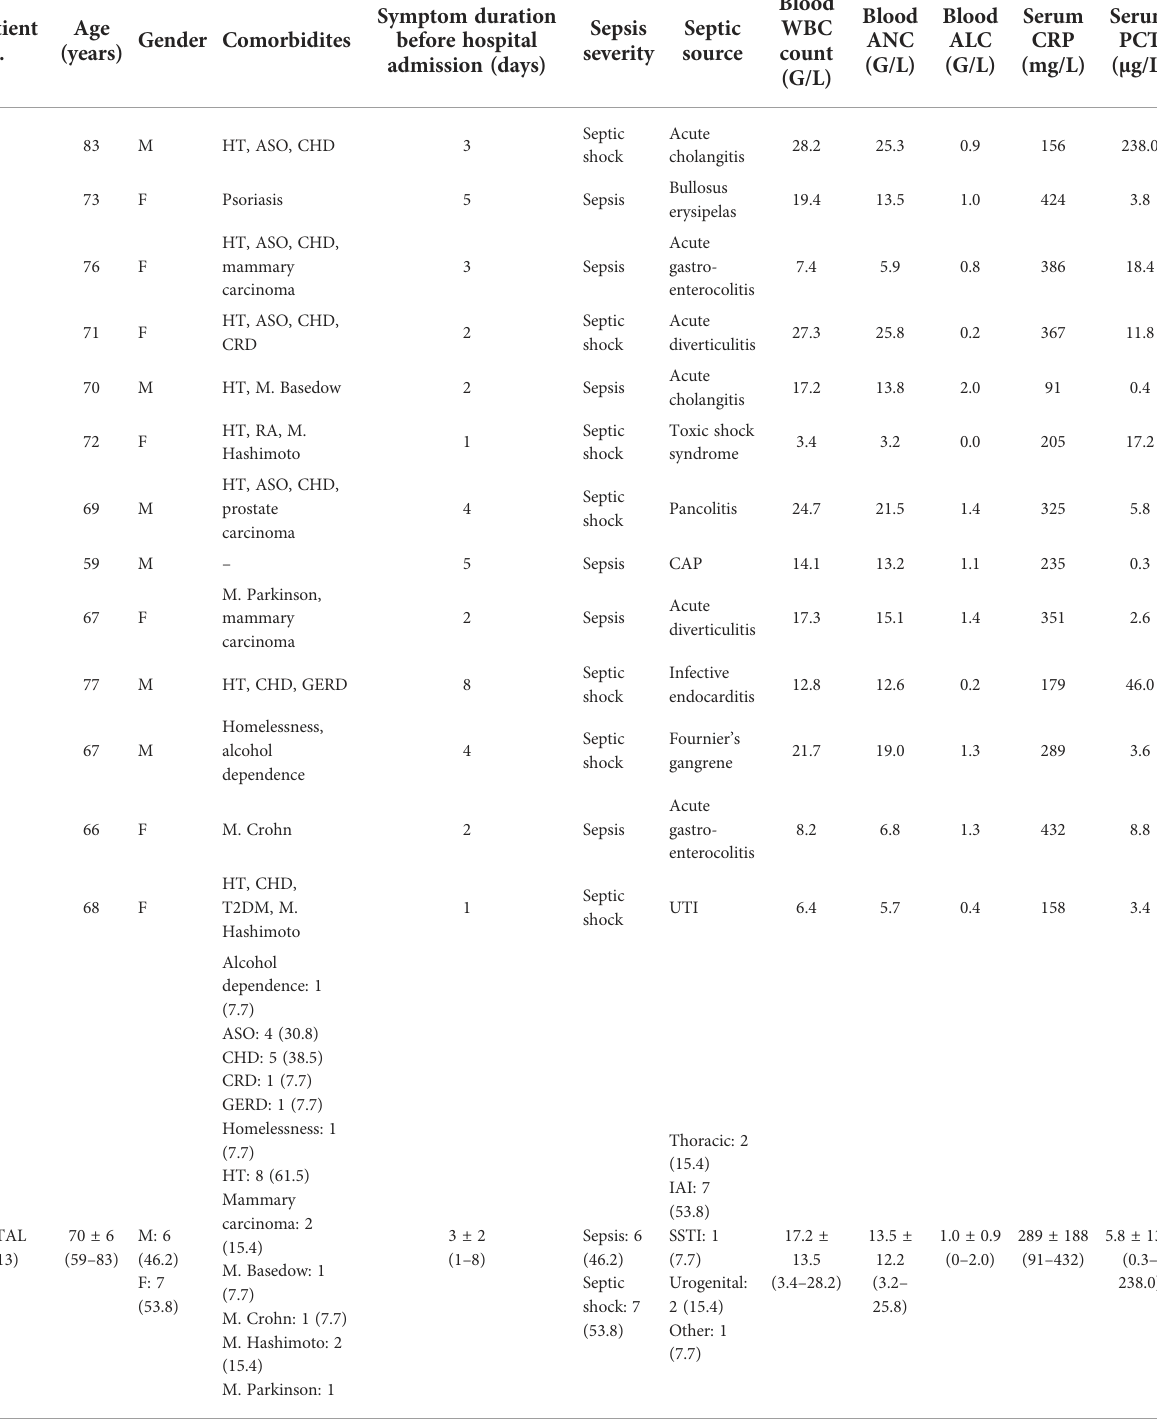
TABLE 1 Baseline characteristics of septic patients included in the study. Septic sources were regrouped according to their gross anatomical regions under the total count.